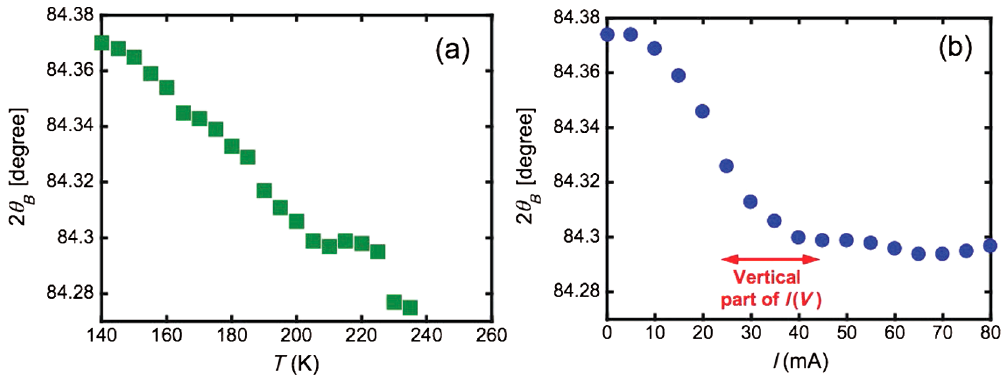
FIG. 5. (a) Bragg reflection (1,1,12) angle 2 θ plotted against temperature T for no current in the crystal. (b) Data for the same reflection plotted versus current at T 0 ¼ 140